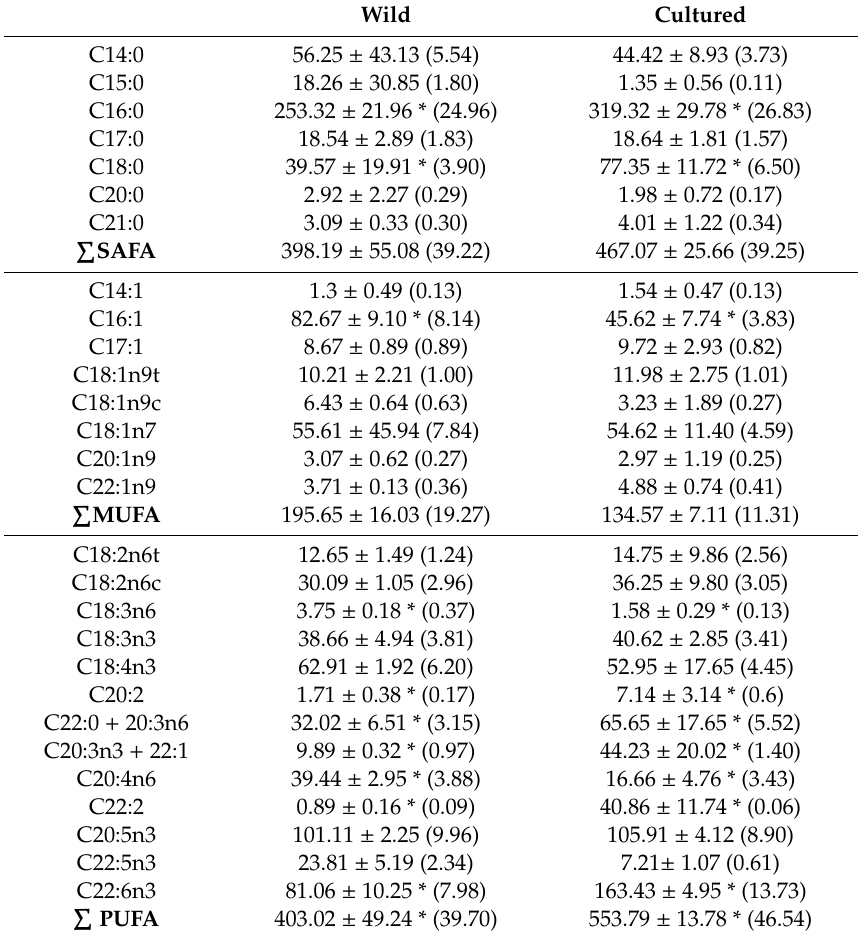
Table 2. Values reported are means ± standard deviations. Fatty acids (FAs) composition (mg / 100 g) in the brackets (% of total FAs) of wild and cultured F. glaber . Means followed by * in the same line are significantly di ff erent ( p < 0.05). Wild